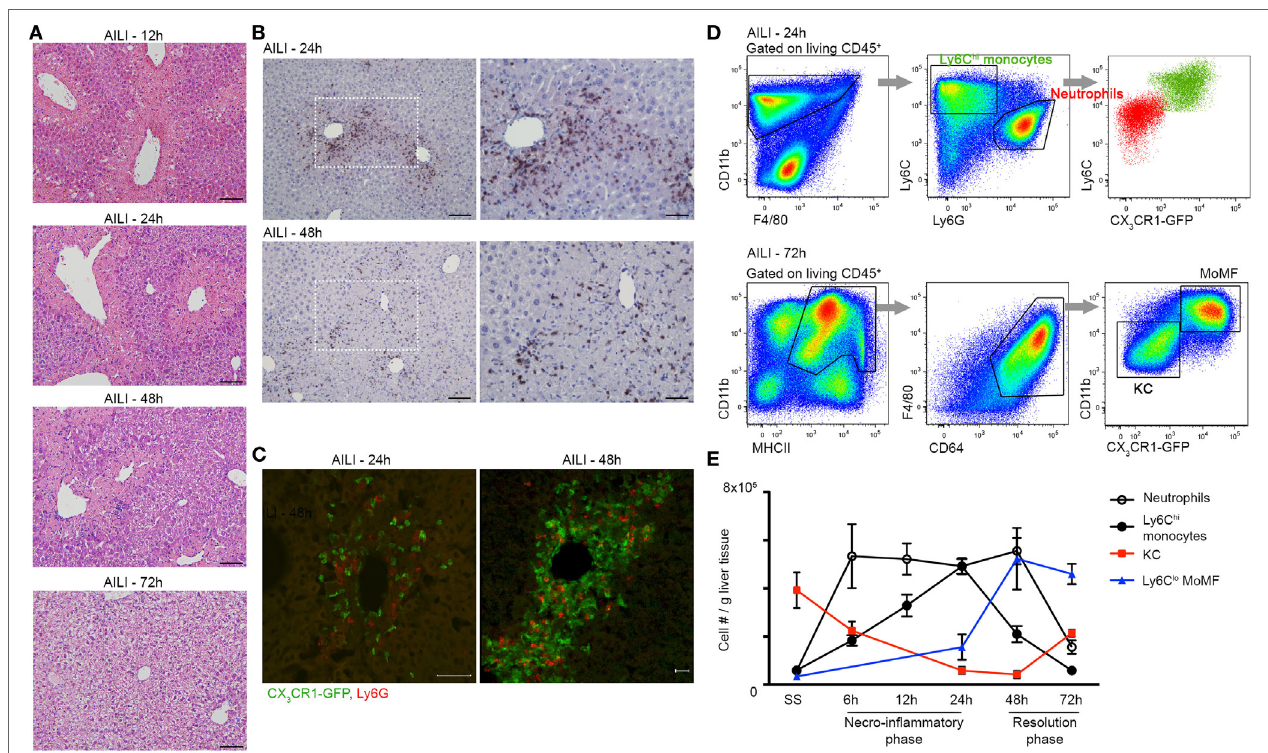
FigUre 1 | liver infiltrating ly6c hi monocytes, monocyte-derived macrophage (MoMF), and neutrophils spatially and temporally coincide at the inflammatory and resolution phases of acetaminophen-induced liver injury (aili) . (a) Hematoxylin and eosin (H&E) staining of liver sections at 12, 24, 48, and 72 h following AILI. Original magnification × 20. Bars, 100 µm. (B) Immunostaining for Ly6G and hematoxylin on paraffin-embedded liver sections at 24 and 48 h after AILI. Original magnifications × 20 (left image) and × 40 (right image). Bars, 100 µm ( × 20) and 85 µm ( × 40). (c) Immunofluorescence staining at 24 and 48 h after AILI in Cx3cr1 gfp/ + mice. At 48 h, 3D-reconstruction was performed of Z-stacks acquired from 20 µm thick slides. In green are infiltrating monocyte-derived cells and in red are neutrophils, which are stained for Ly6G. Original magnification × 20. Bars, 50 µm for 24 h and 20 µm for 48 h. (D) Flow cytometry-based definition of non-parenchymal Cx3cr1 gfp/ + liver cells isolated at 24 h (Ly6C hi monocytes and neutrophils) or 72 h [MoMF and Kupffer cell (KC)] following AILI. (e) Flow cytometry- based analysis of the dynamics of neutrophils and liver-macrophage subsets at steady state (SS) and at different time points following AILI: Ly6G + neutrophils (white), infiltrating Ly6C hi CX 3 CR1-GFP + monocytes (black), resident CX 3 CR1-GFP neg/lo KC (red), and Ly6C lo CX 3 CR1-GFP hi MoMF (blue), presented as cell counts normalized per liver tissue mass in gram. Data are presented as mean ± SEM; n ≥ 5 mice for each time point. Experiments were repeated at least three